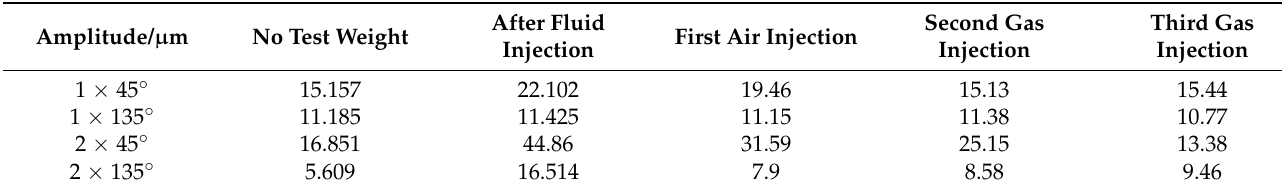
Table 3. Amplitude of each measurement point at 600 rpm.